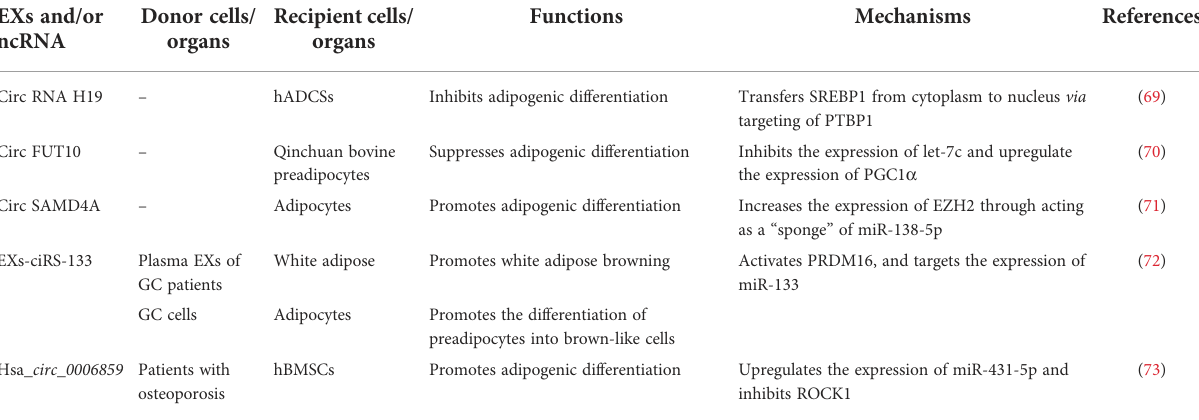
TABLE 2 EXs and/or circRNAs regulate adipogenic